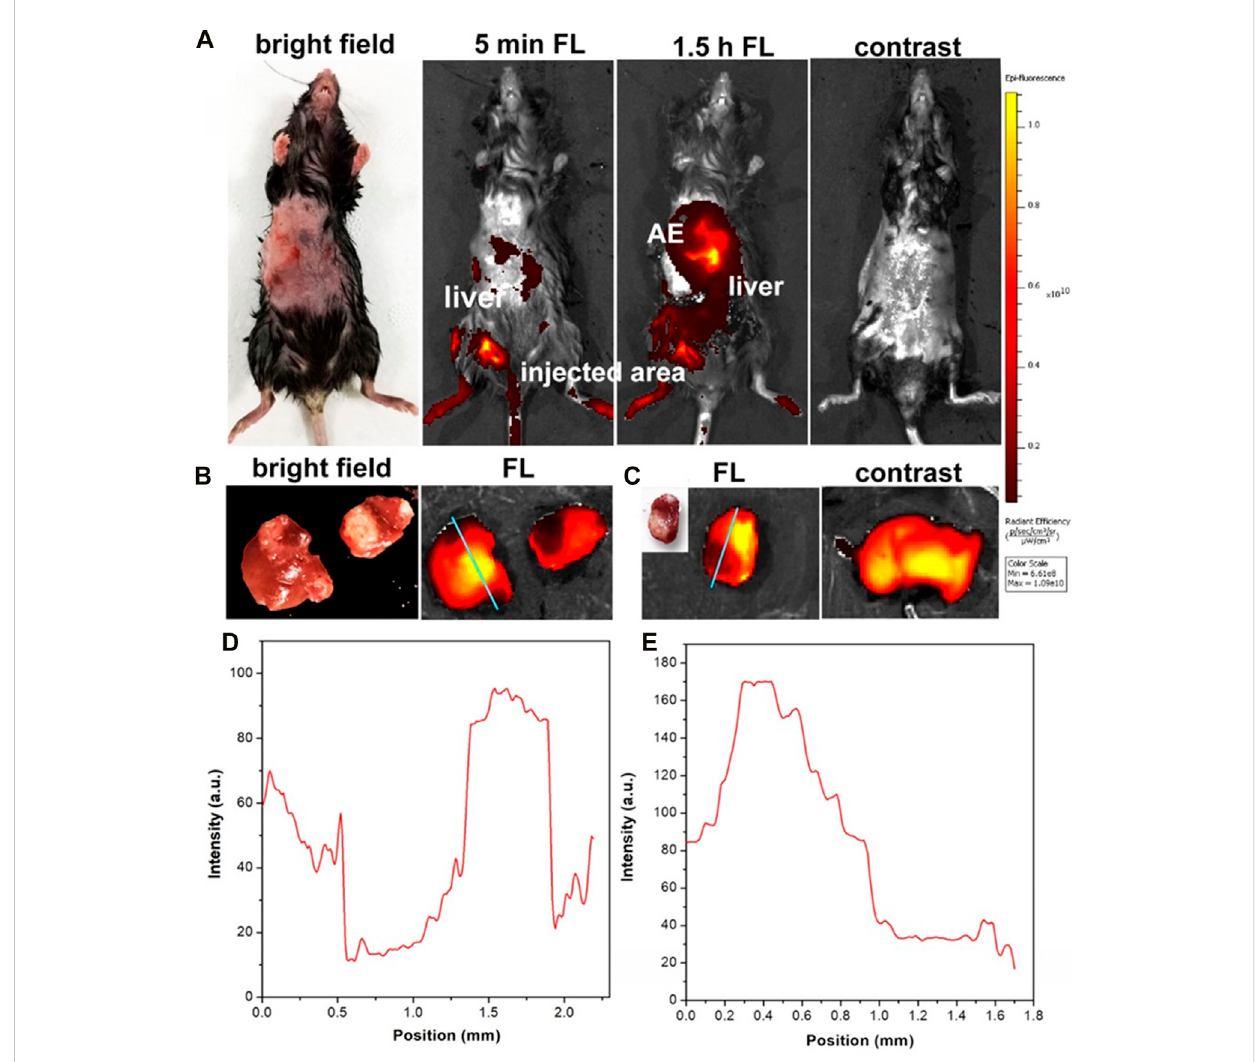
FIGURE 4 (A) Invivo NIR fl uorescence images ofHAE-infected miceatthelate stage withand withouttheinjection ofICG. (B, C) werethelivertissue from the latestageoftheHAE-infectedmouseafterinjectionofICGandinthenormalmouse(control). (D,E) weretheFWHManalysisof (B,C) . λ excitation =740 nm and λ emission = 840